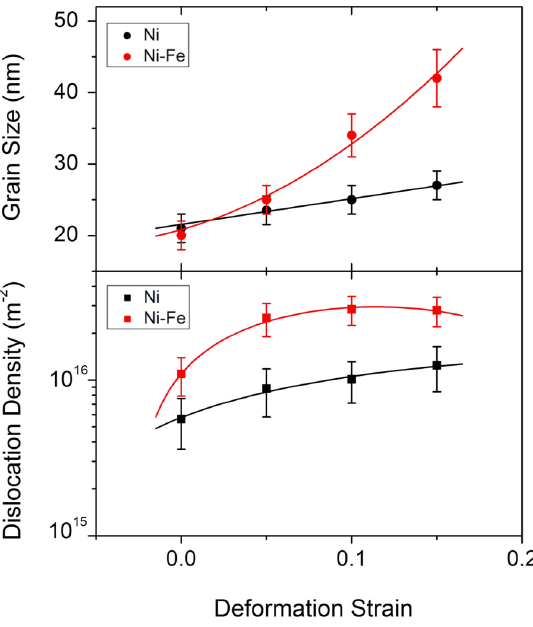
Figure 5: Evolutions of grain size and dislocation density as a func- tion of deformation strain for NC Ni and Ni-Fe